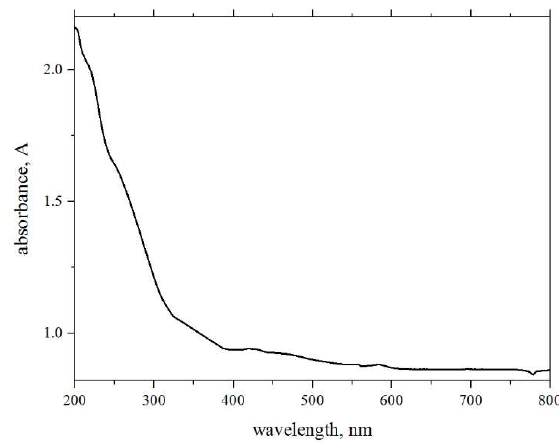
Figure 5. UV/Vis spectrum of 2 registered in KBr pellet.